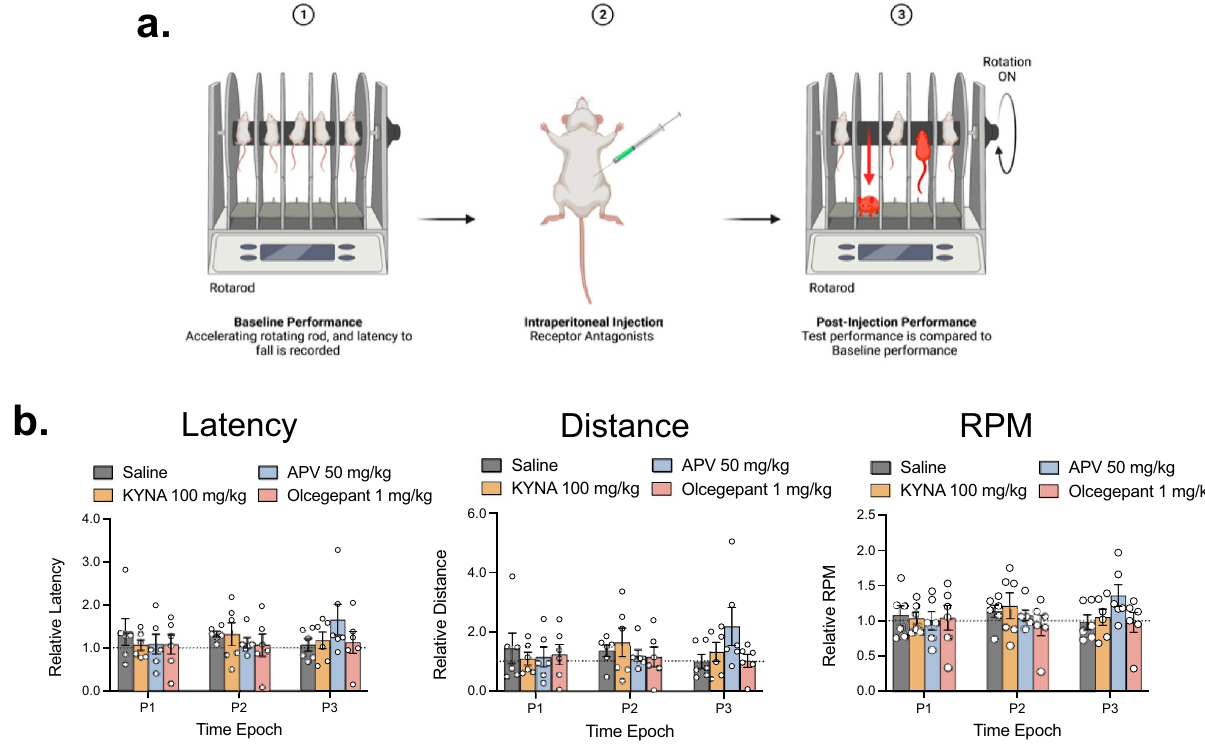
Figure 4. Systemic administration of APV, KYNA and Olcegepant did not induce motor function or balance deficits. Comparison of the effect of APV (50 mg/kg; i.p.), KYNA (10, 50, 100 mg/kg; i.p.), olcegepant (1 mg/ kg; i.p.) and vehicle on motor coordination and balance in 3 male and 3 female rats. ( a ) Schematic diagram illustrating the accelerated rotarod protocol used to assess motor coordination and balance. ( b ) The bar charts show the lack of effect of systemic administration of APV, KYNA and olcegepant on the mean relative latency, distance travelled and speed (RPM). Data are mean ± SEM (n = 6). Symbols represent individual data points. * P < 0.05. Time Epoch = P1 (0–10 min), P2 (10–20 min) and P3 (20–30 min). (Created with personal license of BioRender).